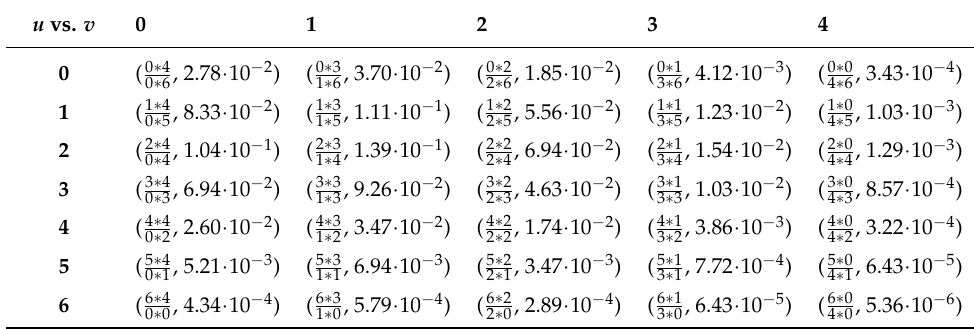
Table A2. Pairs of possible ORs and their associated probabilities ( h 1,2 , f 1,2 ) for the data in Table 2.